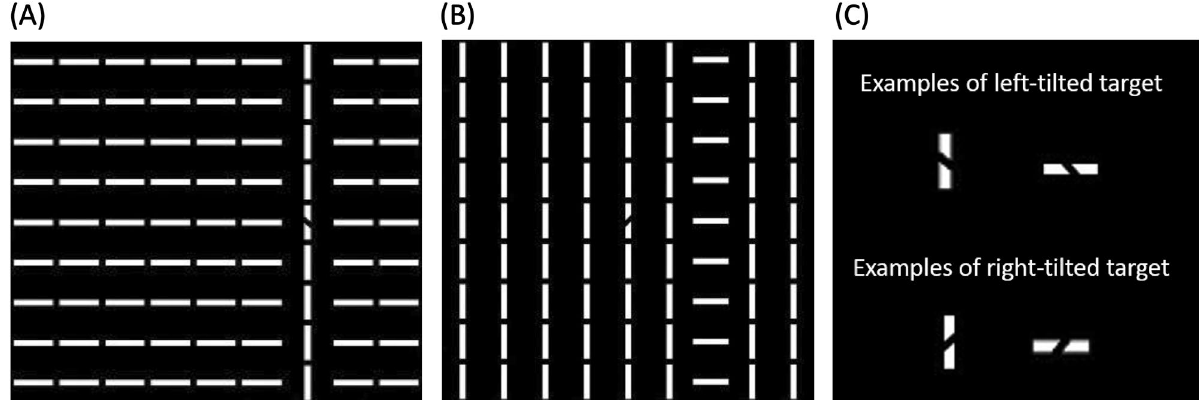
Figure 1. Examples of the search display used in Experiment 1. ( A ) The overlap condition with a collinear distractor: the display contains a collinear distractor (vertical white lines), and the target (i.e., the black leftward- tilted segment) is in the column of the collinear distractor. ( B ) The non-overlap condition with a non-collinear distractor: the display contains a non-collinear distractor, where the black rightward-tilted target is not in the distractor column (horizontal white lines). ( C ) Examples of possible targets in the search display. Regardless of the orientation of the bar, the upper panel presents the left-tilted targets, and the lower panel presents the right- tilted